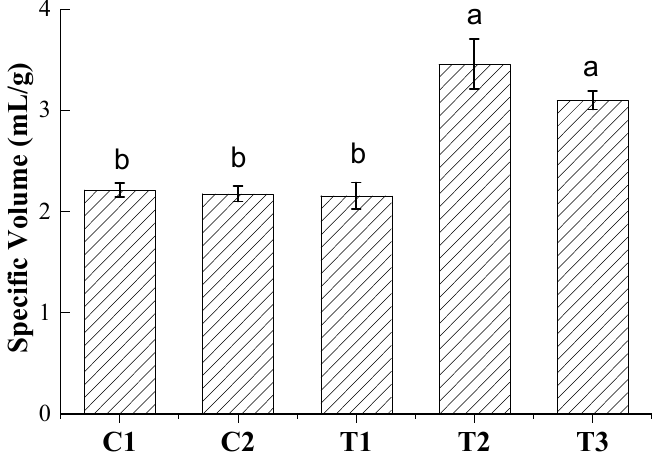
Figure 1. Specific volume of IWG breads ( n = 3) as affected by bran treatment with xylanase and use of ascorbic acid. Different letters signify statistical differences ( p < 0.05) among treatments.